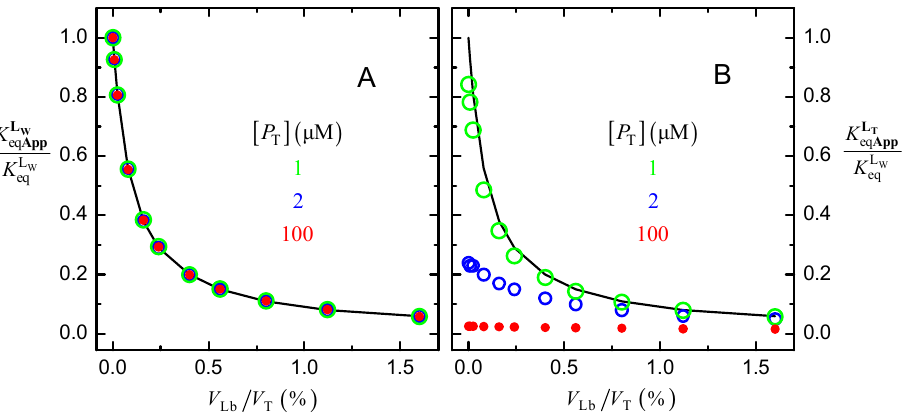
Figure 3. Dependence of the apparent binding affinity on the fractional volume of the lipid bilayer; when considering that the ligand is either in the aqueous medium or associated with the protein ( K L W Equation (6), plot ( A ), and when assuming large excess of ligand ( K L T W L eqApp plot ( B ). The parameters considered in the simulations were: K L W eq = 10 6 M − 1 , and different protein concentrations, as indicated in the plots. The line is the prediction from Equation (8).